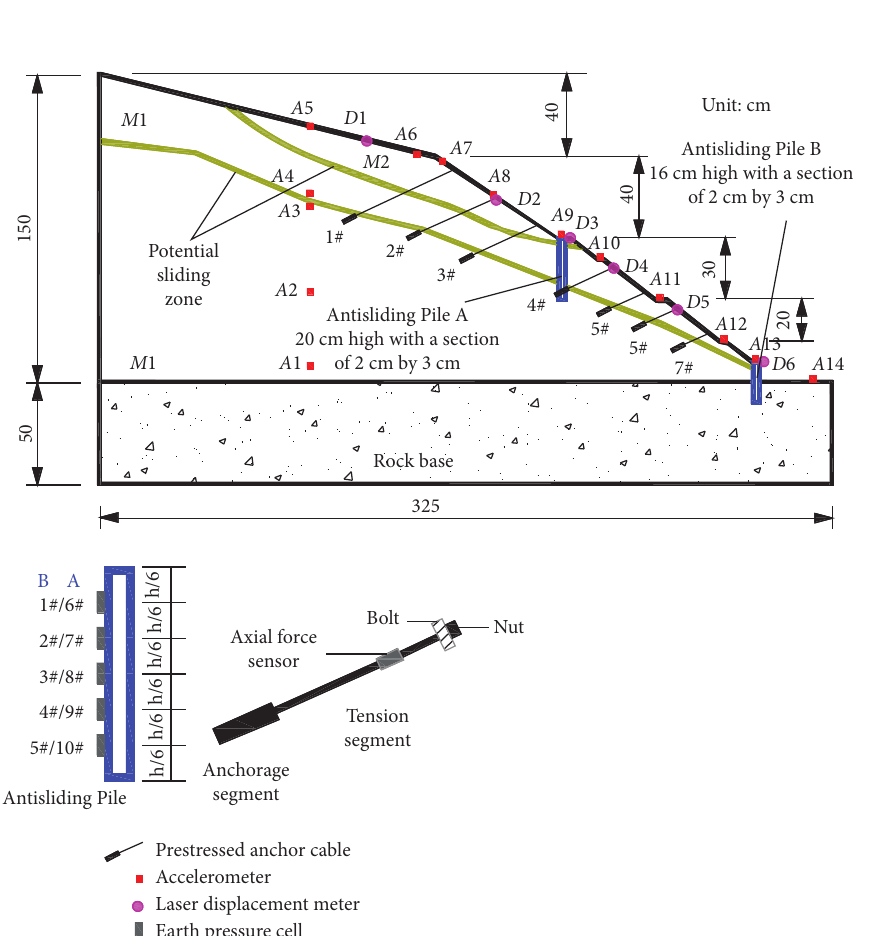
Figure 4: Layout of sensors and detailed views of the antisliding pile and prestressed anchor